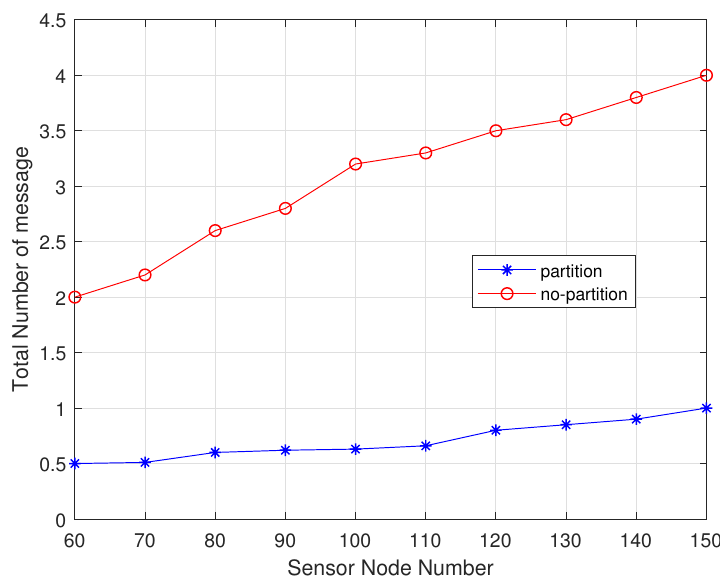
Figure 18. Total number of messages varies with sensor node number.